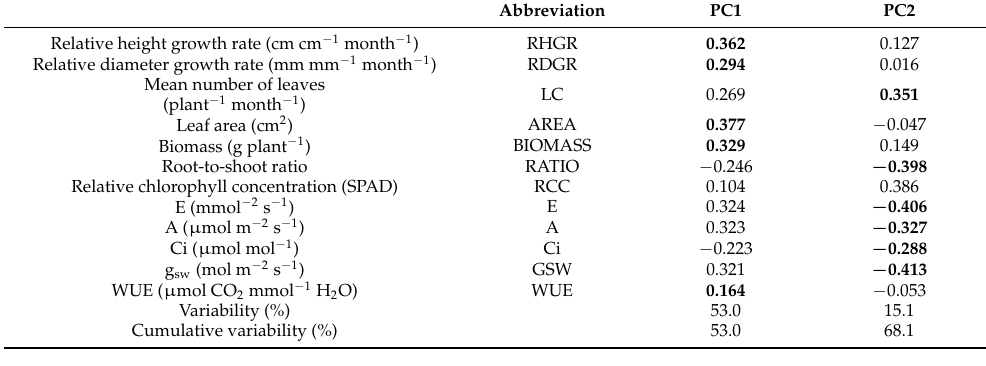
Table 3. Variable loading scores of 12 parameters for two Shorea species ( S . leprosula Miq. and S . acuminata Dyer) in different levels of light irradiance and nutrient amendment and the proportion of variation of each principal component. Figure 9. Root-to-shoot ratio of Shorea leprosula Miq. ( a ) and Shorea acuminata Dyer ( b ) in response to the interaction factor, light × nutrient. Alphabets denote significant differences between light × nutrient interactions.